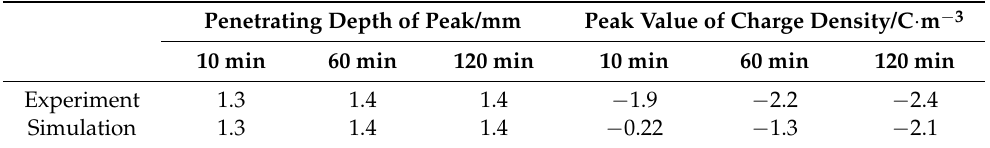
Table 3. Comparison of experiment and simulation results of charge deposition distribution under different radiation times.